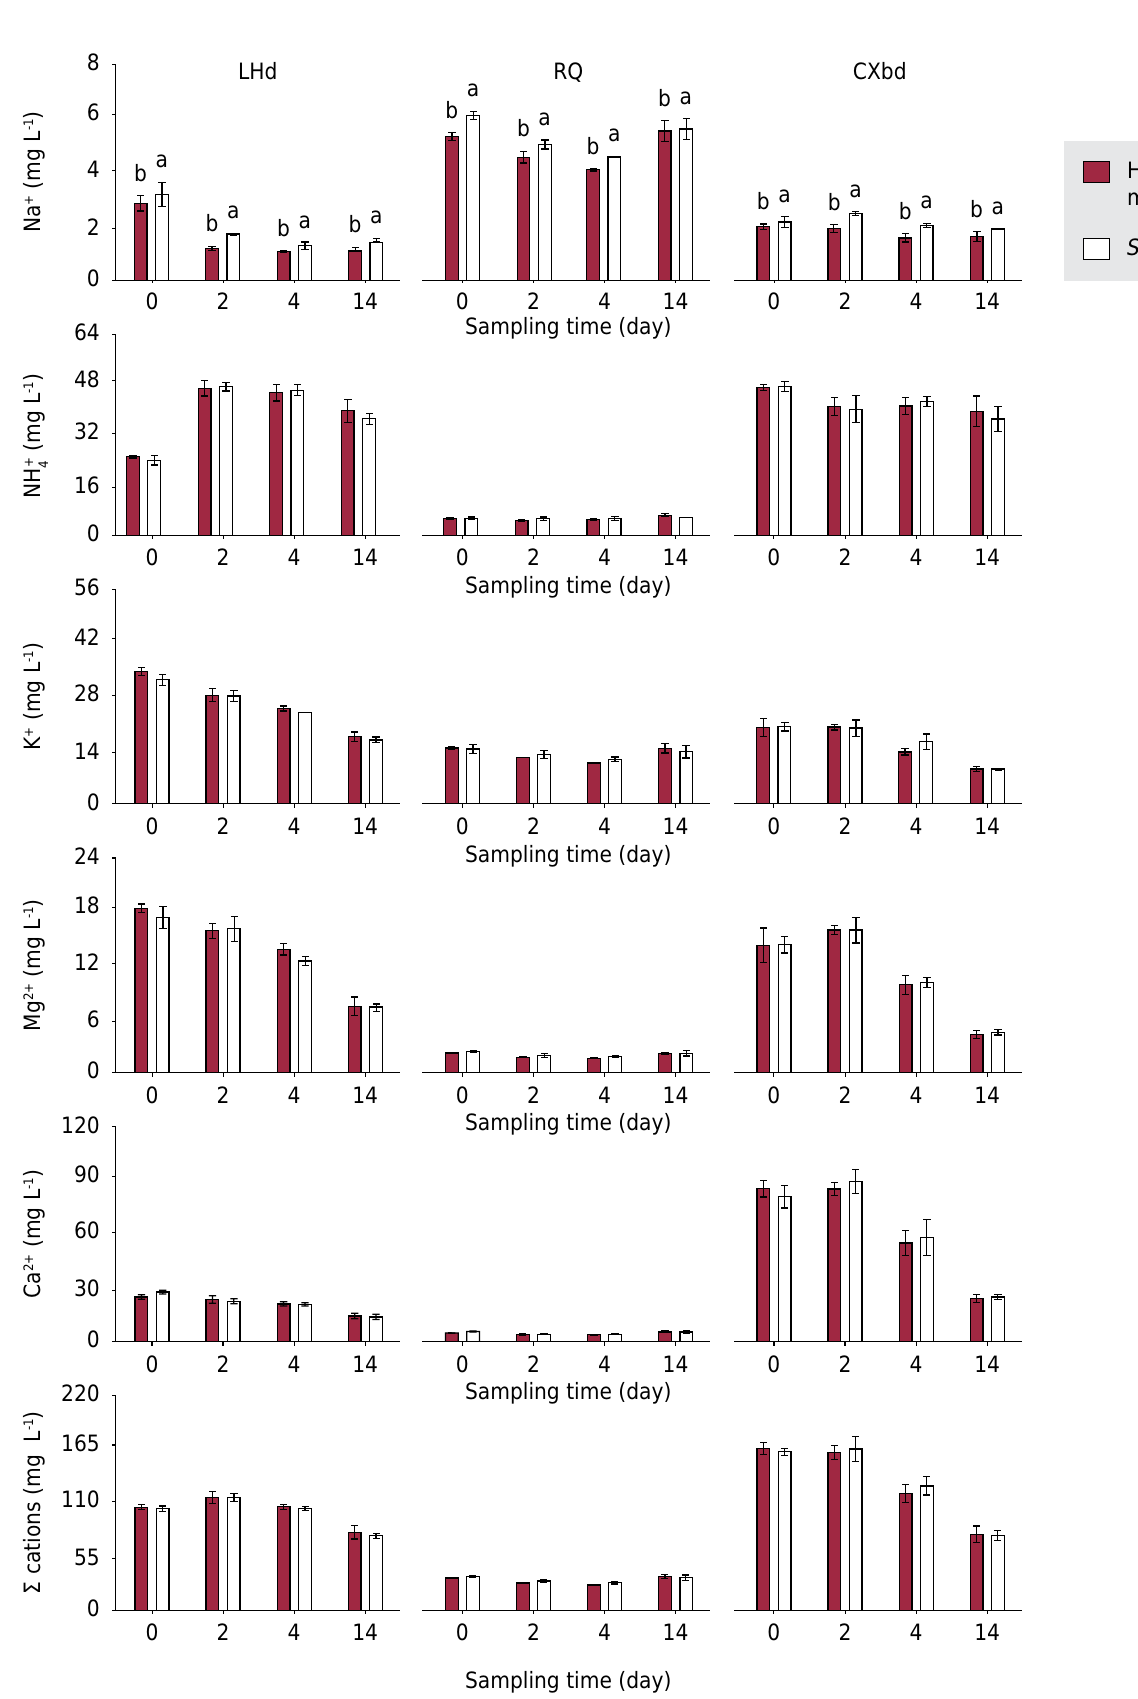
Figure 3. Cation concentrations over the sampling period in solutions of the studied soils. Soil solutions were collected by the Suolo Acqua and hydrophilic membrane (HM) samplers. Na + = exchangeable sodium; NH + 4 = ammonium; K + = exchangeable potassium; Mg 2+ = exchangeable magnesium; Ca 2+ = exchangeable calcium. LHd - Latossolo Húmico Distrófico , RQ - Neossolo Quartzarênico and CXbd - Cambissolo Háplico Tb Distrófico . Mean values followed by the same letter do not differ statistically by the F test